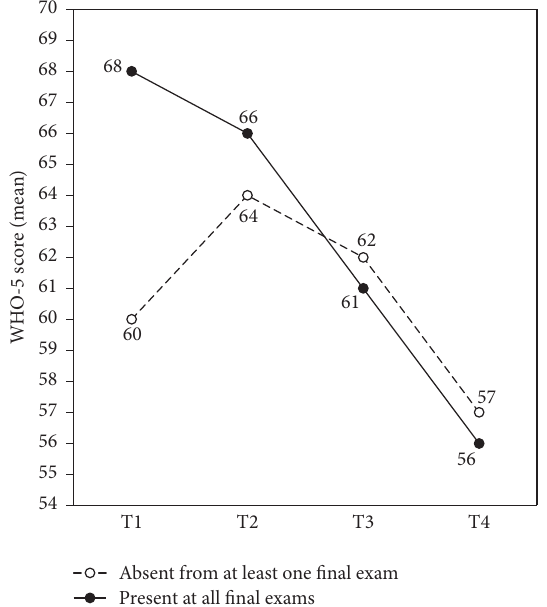
Figure 5: Subgroup analysis of the change of dental students’ positive well-being, according to their attendance of final exams.